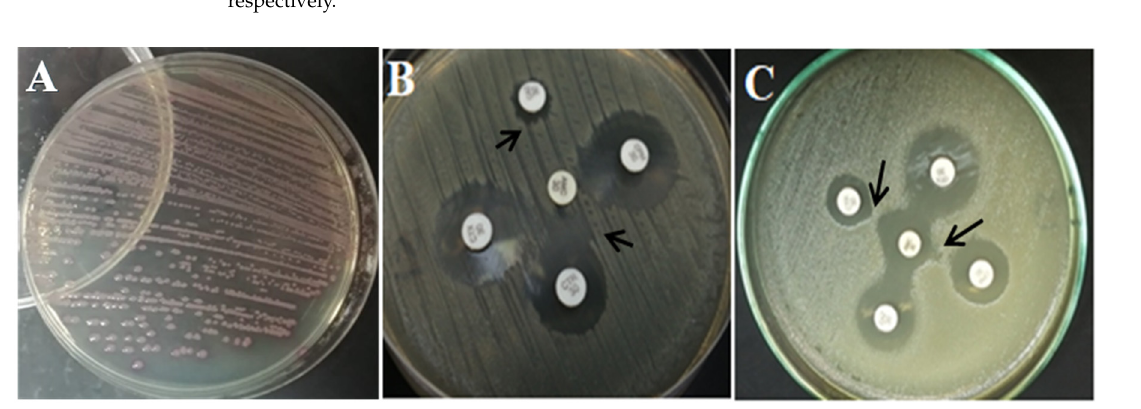
done by using the DDST on four discs of cephalosporins antibiotic, i.e., cefotaxime, ceftriaxone, cef-